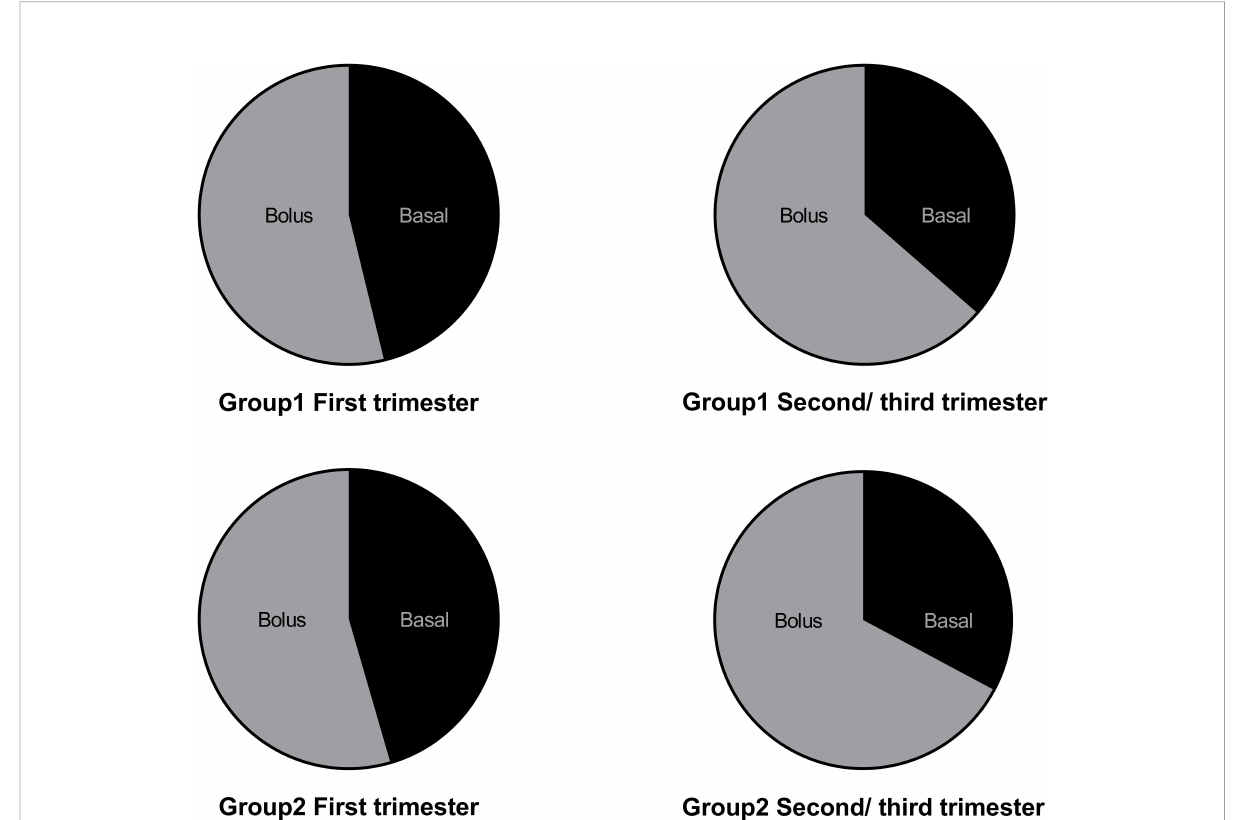
FIGURE 3 Comparison of percentage of preprandial insulin between Group 1 and Group